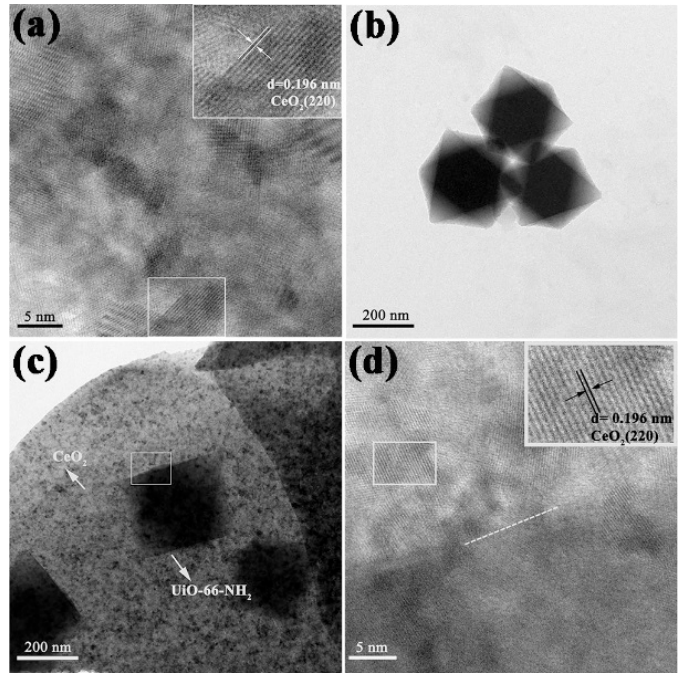
Figure 10. TEM and HRTEM images of samples: ( a ) CeO 2 ; ( b ) UiO-66-NH 2 ; ( c ) 400 °C 1-Ce/UN composites; ( d ) magnified HRTEM image of the white box labelled in ( c ).